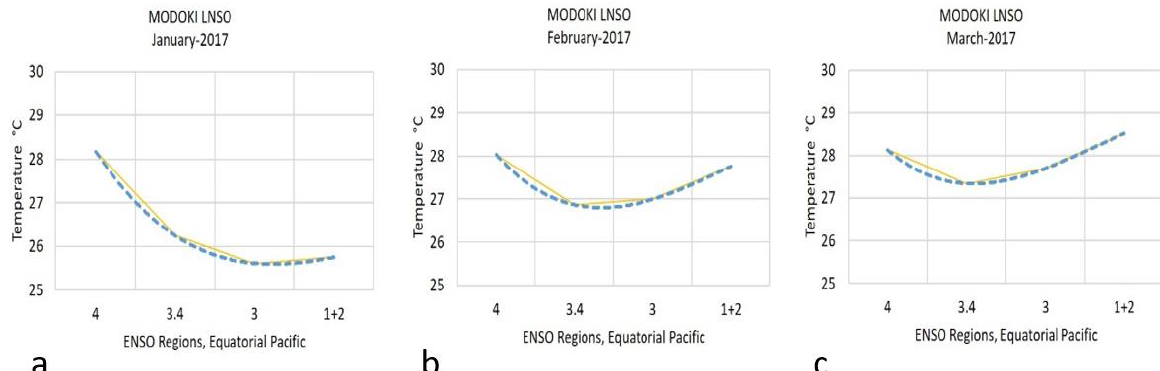
Figure 10. Pacific Regional Equatorial Index (PREI). ( a ) January 2017, in regions 3.4 and 3, a low value of the SST (25 °C) is observed, which indicates the presence of the Modoki LNSO and the region 1 + 2, also presents a low value of the SST (25.8 °C). ( b ) February 2017, in regions 3.4 and 3, a slight increase in SST (26.8 C) is observed, but in region 1 + 2 a greater increase in SST (27.9 °C) is observed, indicating the presence coastal ENSO. ( c ) March 2017, in region 1 + 2, an increase in SST (28.7 °C) was observed, in relation to the month of February and presenting the greatest effects of the Coastal ENSO.